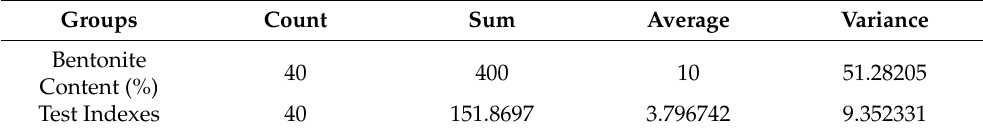
Table 6. Single-factor ANOVA results.